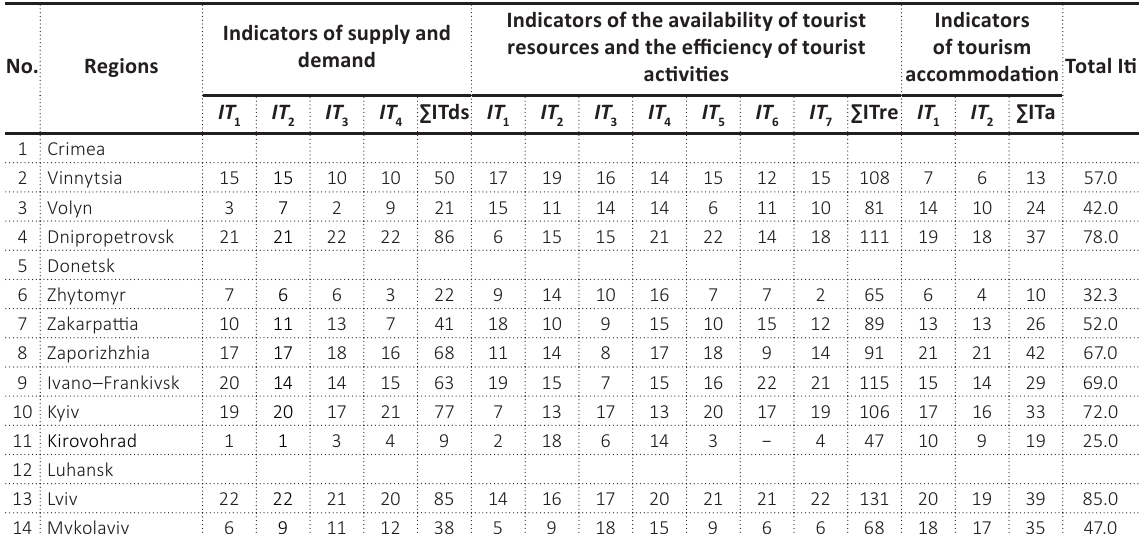
Table G1. Indicators of tourism accommodation in the regions of Ukraine in 2020